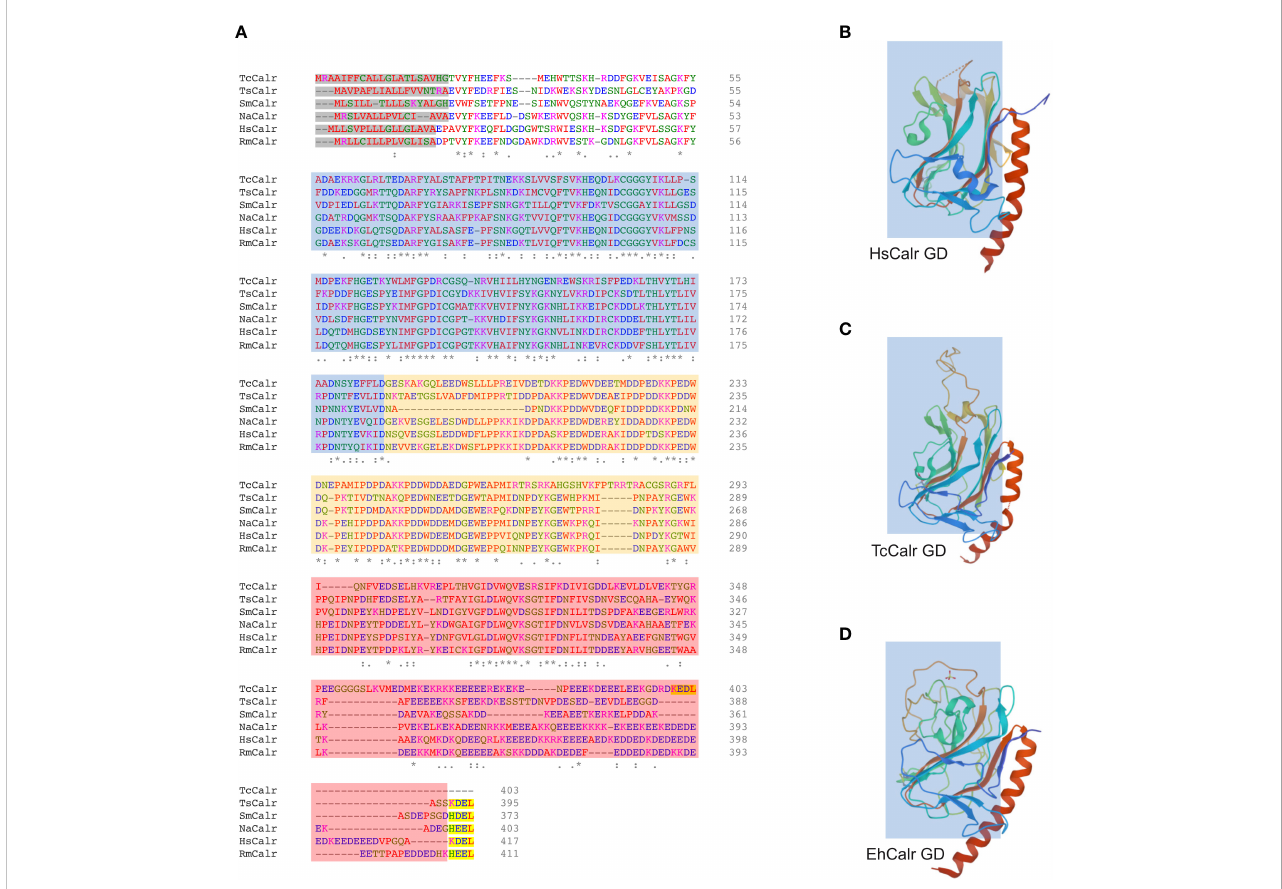
FIGURE 1 Alignment of different parasite Calr with HsCalr and crystal structure of the globular domain of TcCalr, EhCalr and Hs Calr. (A) Amino acid sequences were align using the ClustalOmega (1.2.4) tool. Signal peptide is highlighted in gray, the ER retention signal is in yellow. N, P, and C domains are shaded in blue, orange and red respectively. Genebank accession numbers: TcCalr: Trypanosoma cruzi calreticulin, AAD22175.1; TsCalr: Taenia solium calreticulin, AAK52725.1; SmCalr: Schistosoma mansoni calreticulin, AAA19024.1; NaCalr: Necator americanus calreticulin, CAA07254.1; HsCalr: Homo sapiens calreticulin, AAA51916.1; RmCalr: Rhipicephalus microplus calreticulin, AAR29940.1. An * (asterisk) indicates positions which have a single, fully conserved residue; a: (colon) indicates conservation between groups of amino acids with strongly similar properties; a . (period) indicates conservation between groups of weakly similar properties. (B) Homo sapiens recombinant globular domain, PDB ID: 3POS; X-ray diffraction 1.65 Å (30); (C) Trypanosoma cruzi strain CL Brener; recombinant globular domain, PDB ID: 5HCF; X-ray diffraction 2.15 Å (34); (D) Entamoeba histolytica strain HM-1: IMSS; recombinant globular domain in complex with glucose, PDB ID: 5HCA; X-ray diffraction 2.15 Å